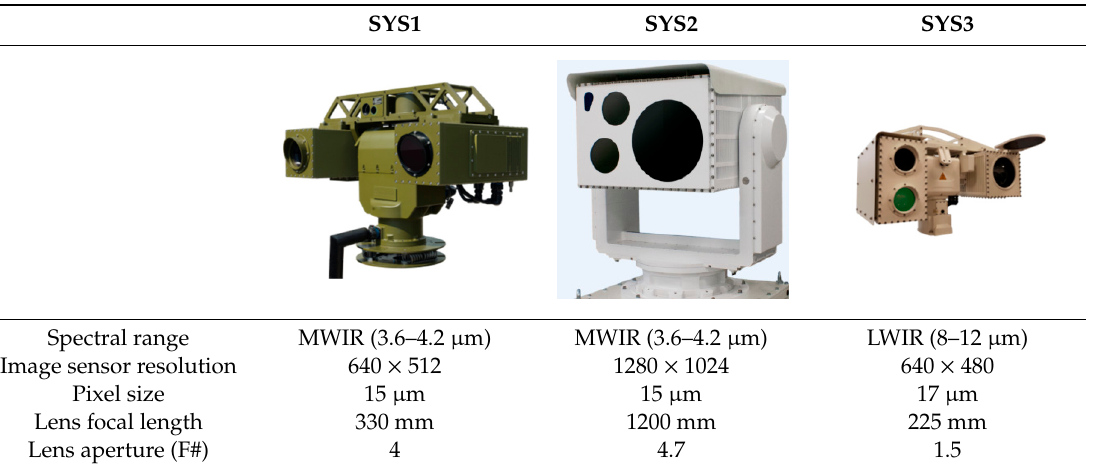
Table 6. Technical specifications of the multi-sensor imaging systems used in the tests.